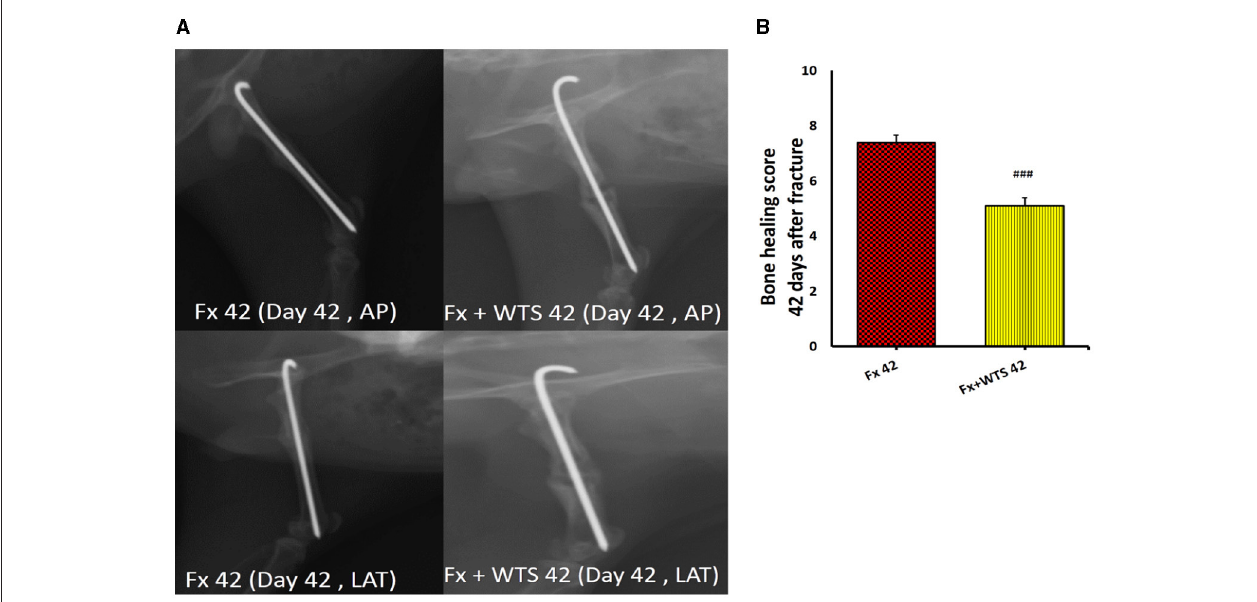
FIGURE 6 | Radiographic evaluation revealed WTS decreased the process of fracture healing 42 days after fracture. (A) X-ray images of lateral and AP view of the femur. (B) The score of bone healing in experimental groups. Fx 42: group subjected to room air for 42 days after surgery and a femoral bone fracture, Fx + WTS 42: group subjected to WTS for 42 days after surgery and a femoral bone fracture. The results are presented as mean ± SE, n = 10. ### P < 0.01 vs. Fx 42.